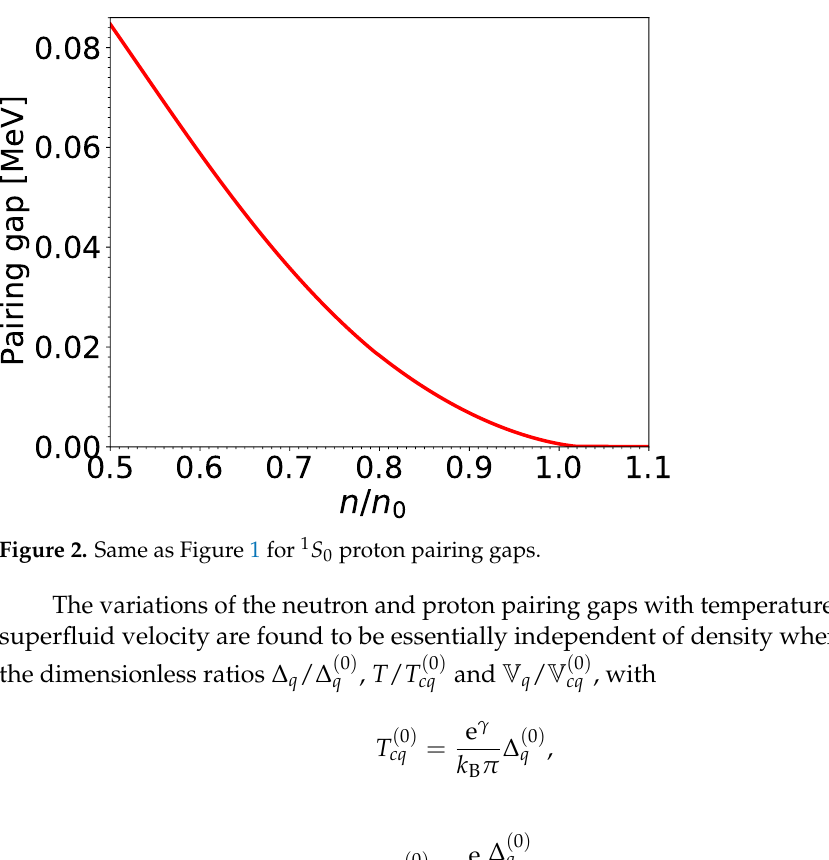
Figure 1. 1 S 0 neutron pairing gaps (in MeV) at zero temperature and in the absence of currents for npe µ matter in beta-equilibrium as a function of the baryon density n in units of saturation density n 0 . The pairing gaps obtained from (77) are indistinguishable from the exact ones.